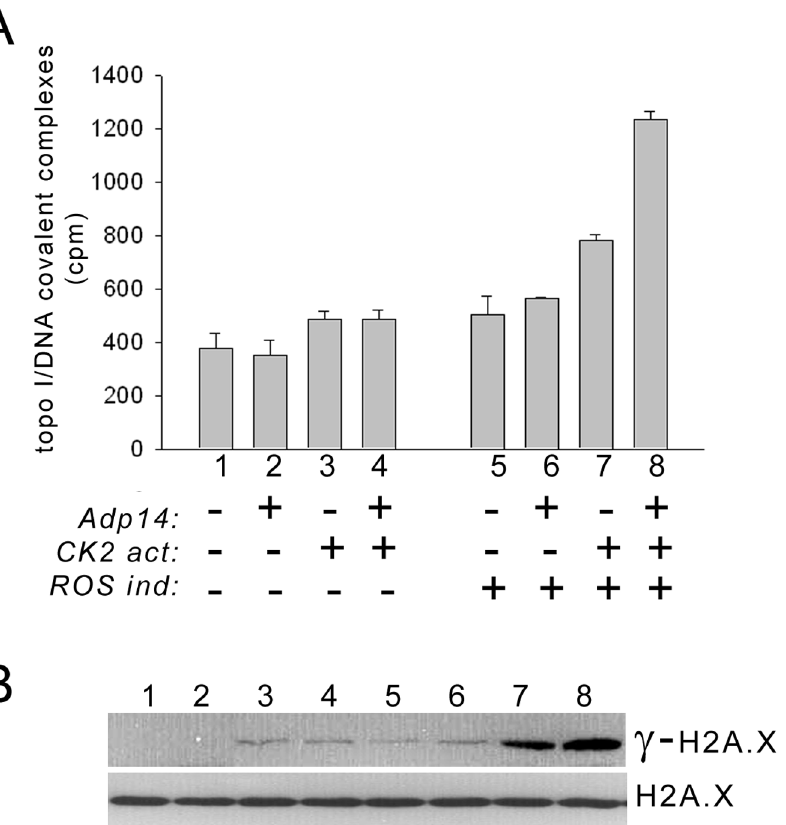
Figure 4. Topo I cleavage complex formation and induction of DNA double-strand breaks. (A) Cleavage complex formation in untreated OVCAR-3 cells (bars 1,5), or 2 days after treatment with 20 moi Adp14 (bars 2,6), 10 nM of the CK2 activator 1-ethyl, 4,5 dicarbamoyl imidazole (bars 3,7), or both Adp14 and the CK2 activator (bars 4,8). Samples 5–8 were also treated with 10 m M of the ROS inducer pyocyanin. Cells were pulsed with [ 3 H]-thymidine to label DNA, cleavage complexes were captured by K + SDS precipitation, and DNA was quantified by scintillation counting. (B) Western analysis of c -H2A.X, an indicator of DNA double-strand break formation, in lysates of H358 cells subjected to the same treatments 1–8 as in part (A). Total H2A.X levels are shown as a control.